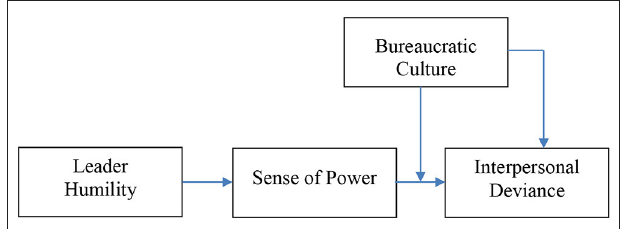
FIGURE 1 | Hypothesized